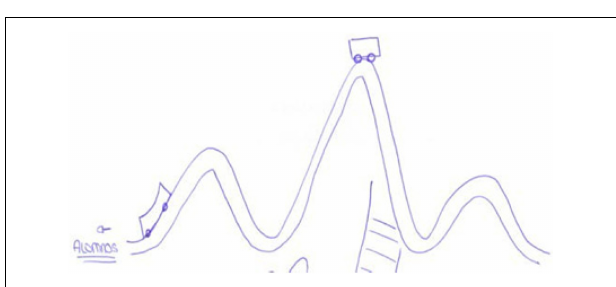
FIGURE 13 | Drawings of the roller coaster as metaphor for the